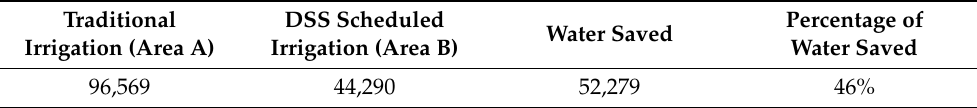
Table 1. Irrigation statistics (L).